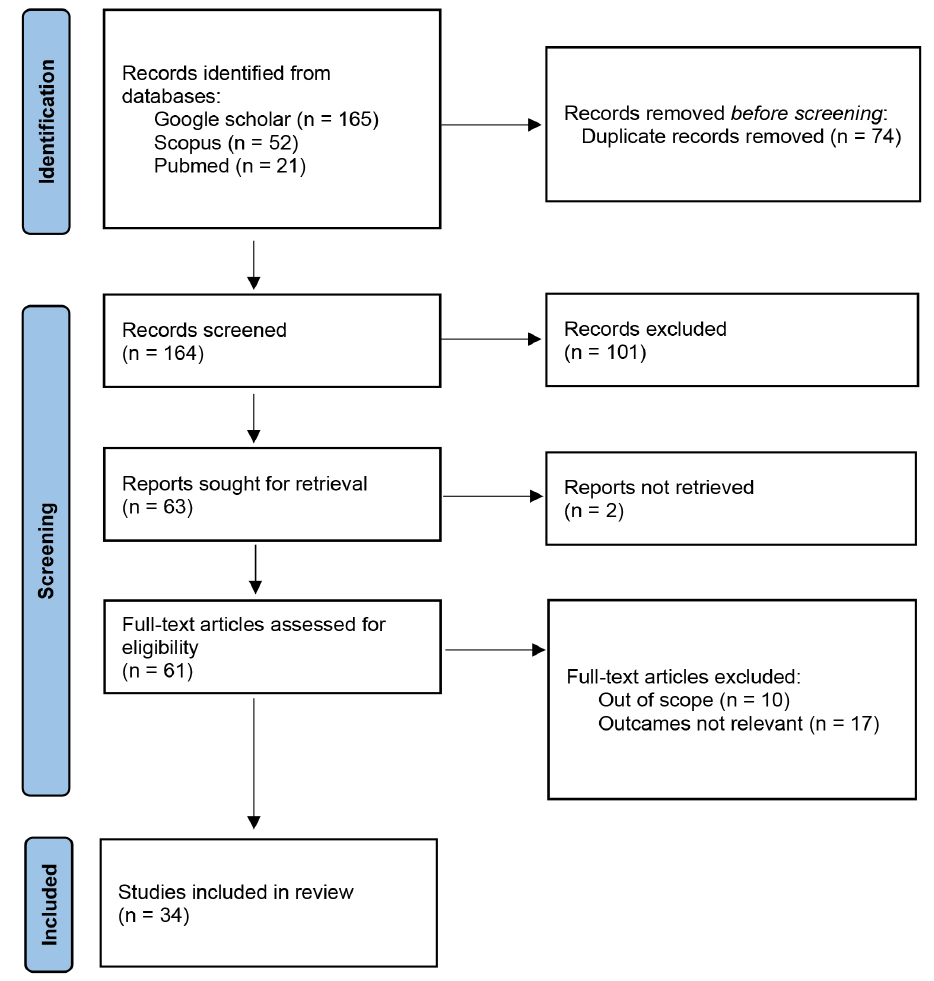
Figure 1. Selection process of the bibliographic sources based on a PRISMA 2020 flow diagram.